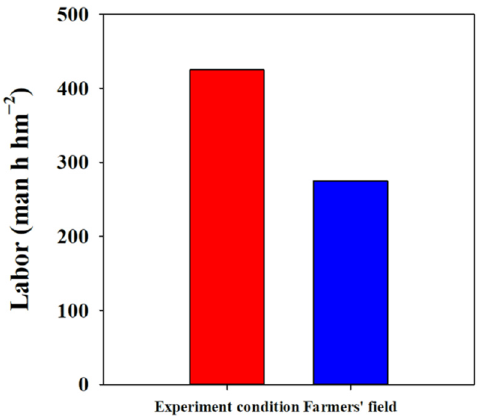
Figure 5. The labor input for MAT in experiment conditions and at farmers’ fields. The data of these were the mean value in our previous five years’ field experiment and the average value in the surveyed study. Data were pooled from examinations conducted in 2020.